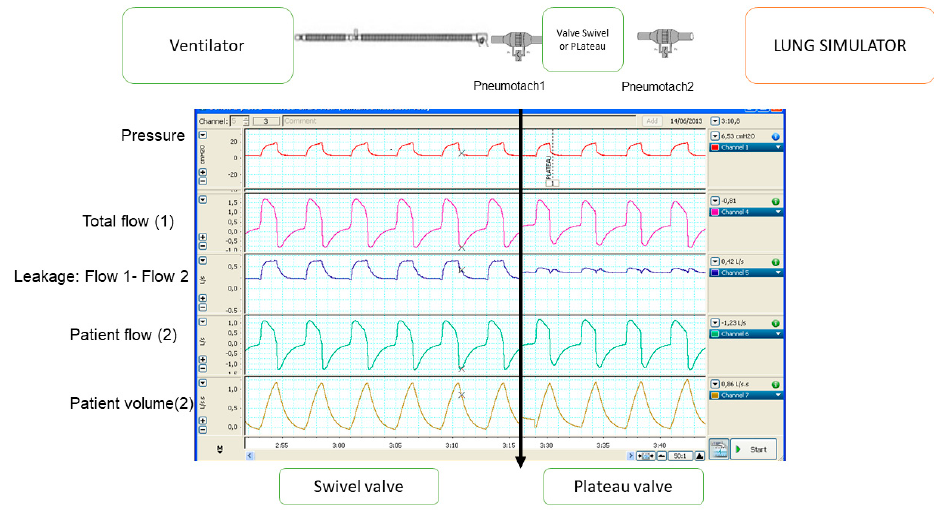
Figure 5. Comparison of intentional leakage between Swivel and Plateau valves. See the text for more details.